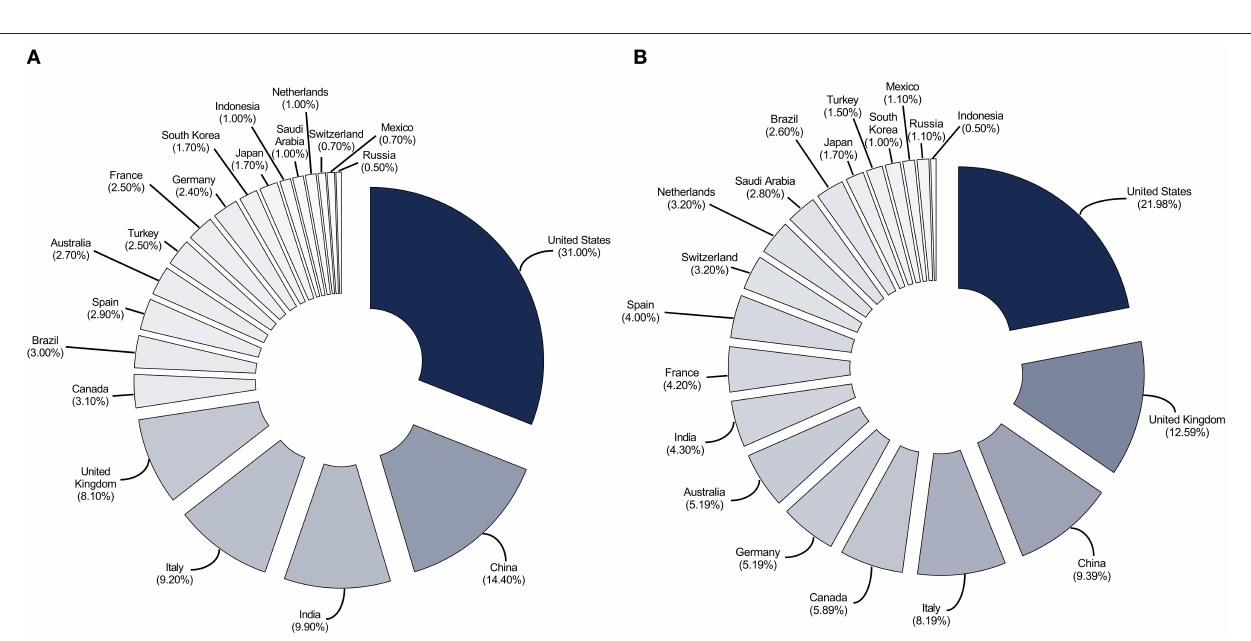
FIGURE 2 | The proportion of early publications involving authorship from a single country (A) and multiple countries (B) on COVID-19 from the 20 highest-ranked countries according to gross domestic product.